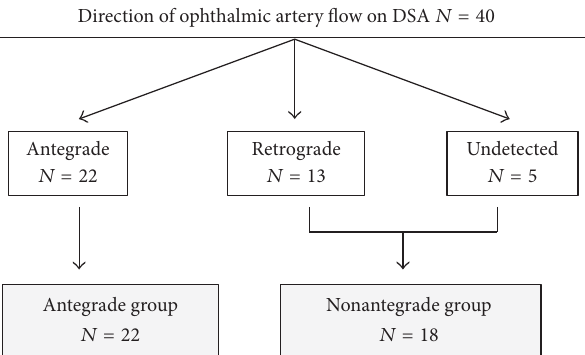
Figure 3: Classification of study participants by direction of oph- thalmic artery blood flow on digital subtraction angiography (DSA). All the participants were classified into 3 groups and recategorized 2 groups for the purpose of this